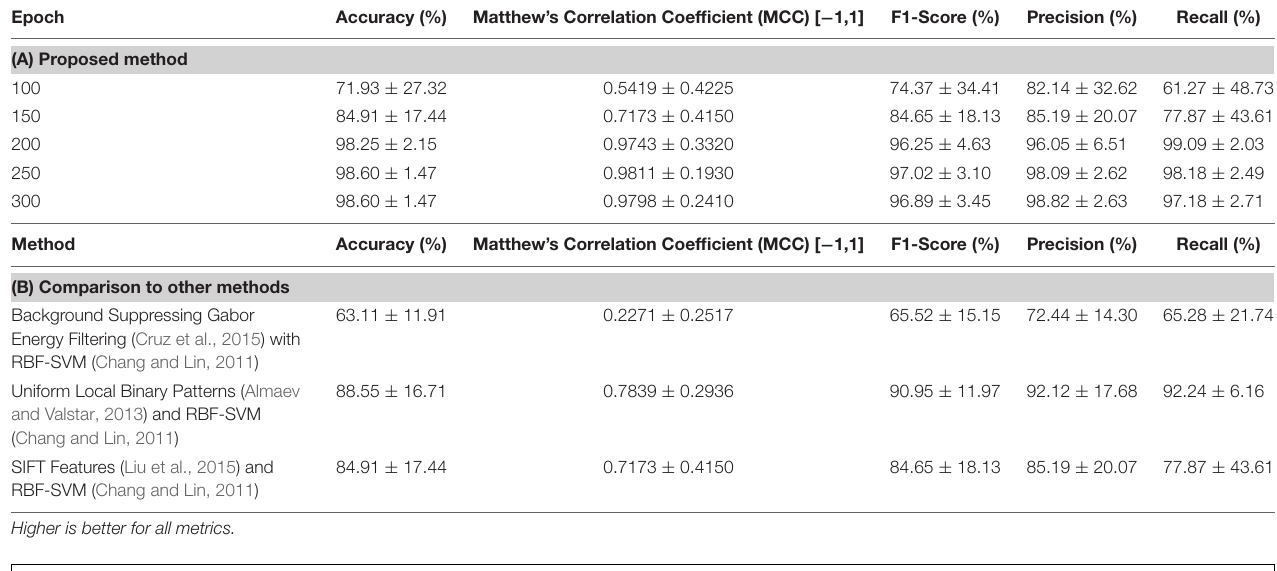
TABLE 2 | Accuracy, Matthew’s Correlation Coefficient (MCC), F1-Score, Precision and Recall of predicting symptoms of Olive Quick Decline Syndrome (OQDS) in images of Xylella fastidiosa -positive leaves of Olea europaea L. amongst healthy controls (asymptomatic leaves) or X. fastidiosa -negative leaves showing other disorders.